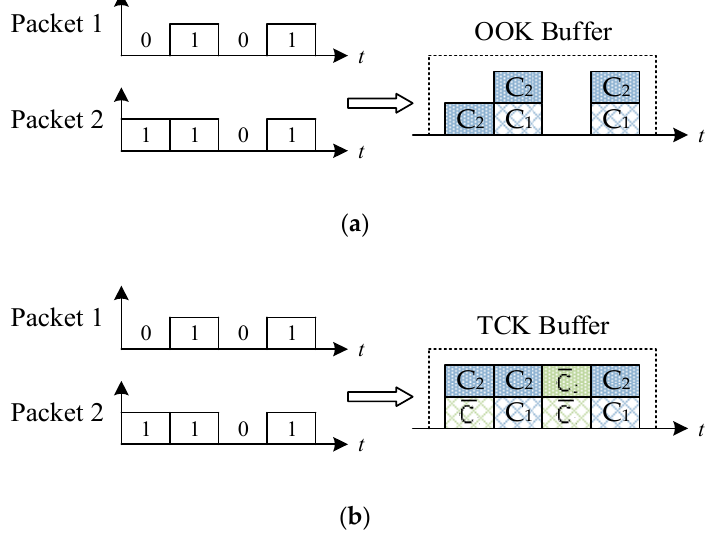
Figure 2. Optical coding scheme for buffered packets: ( a ) on–off keying (OOK) and ( b ) two-code keying (TCK).